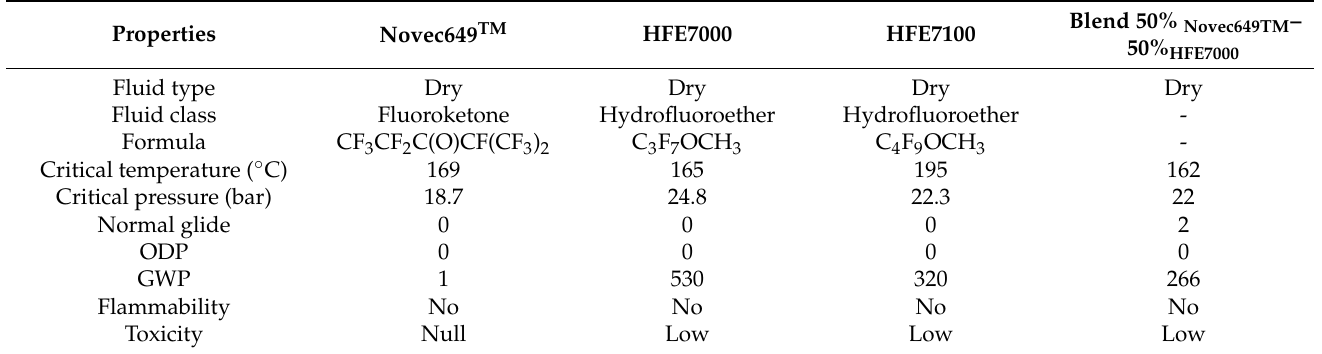
Table 2. Main properties of the working fluids studied.